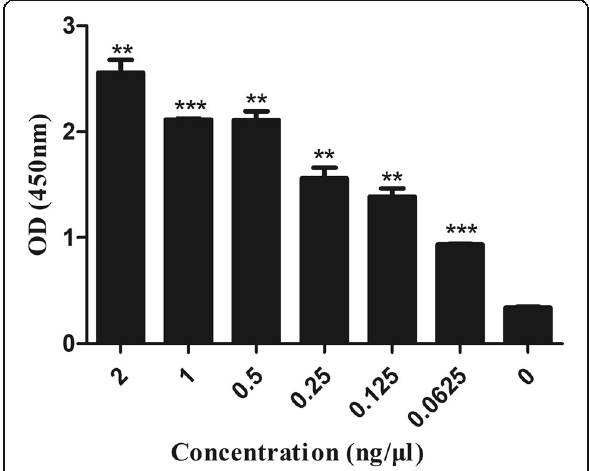
Fig. 2 ELISA method to detect N-PAMAM-IgG (goat anti-rabbit) antibody resistance. N-PAMAM-IgG was used as an antigen and diluted to different concentrations. Rabbit IgG-HRP was used as an antibody probe to detect the resistance of N-PAMAM-IgG. The absorbance measurement was taken at a wavelength of